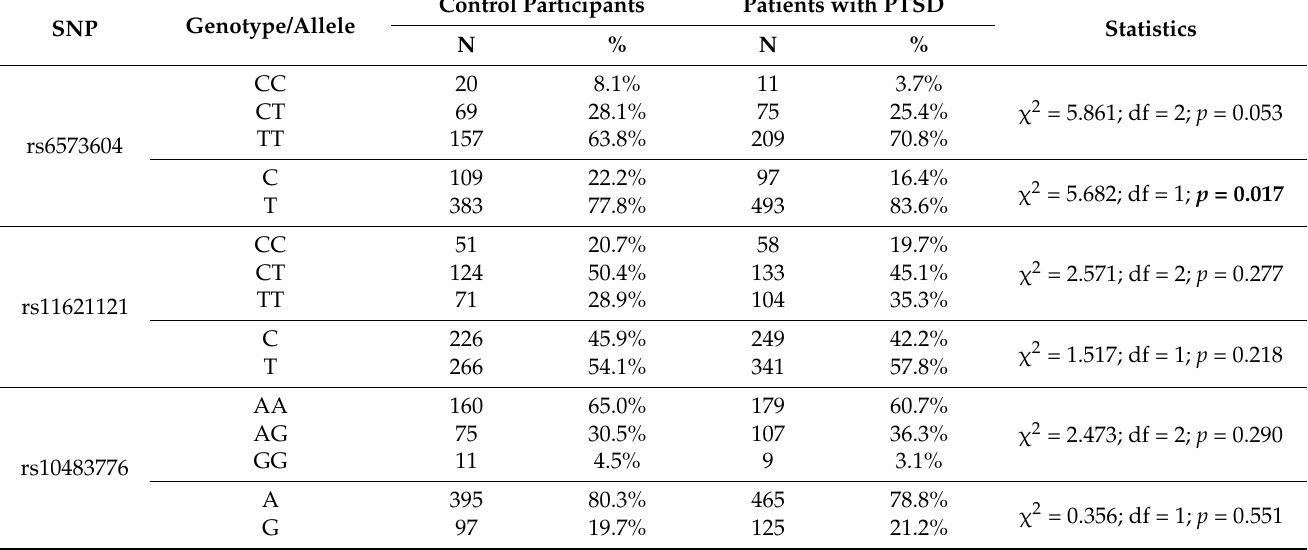
Table 2. Distribution of the genotypes and alleles of the rs6573604, rs11621121, rs10483776, and rs4073416 polymorphisms in the control participants and the patients with PTSD.